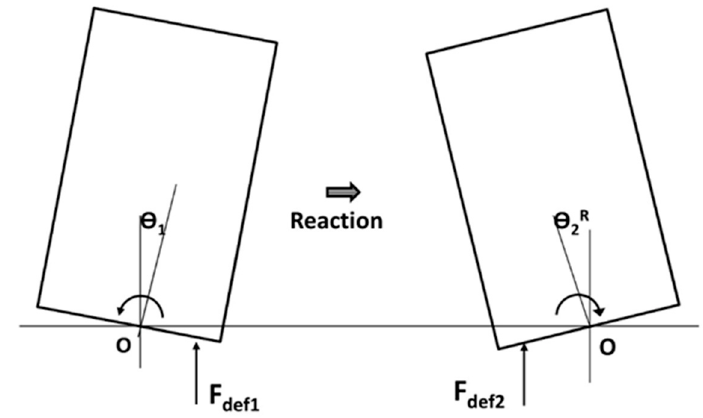
Figure A4. Damping of the turn due to soil reaction. (F def —resistance of the soil to deformation produced by the rotation).